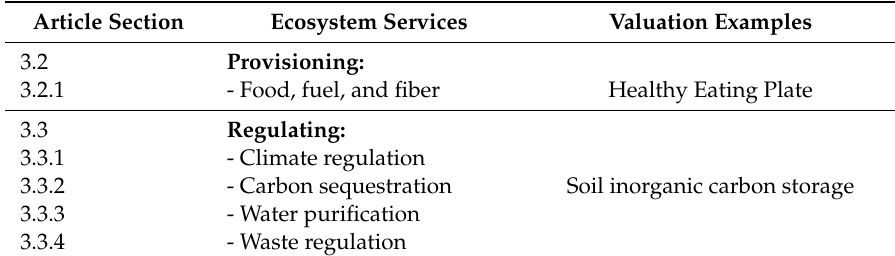
Table 2. Article sections addressing selected ecosystem services, disservices, challenges, and valuation examples in relation to the soil resources of Libya.